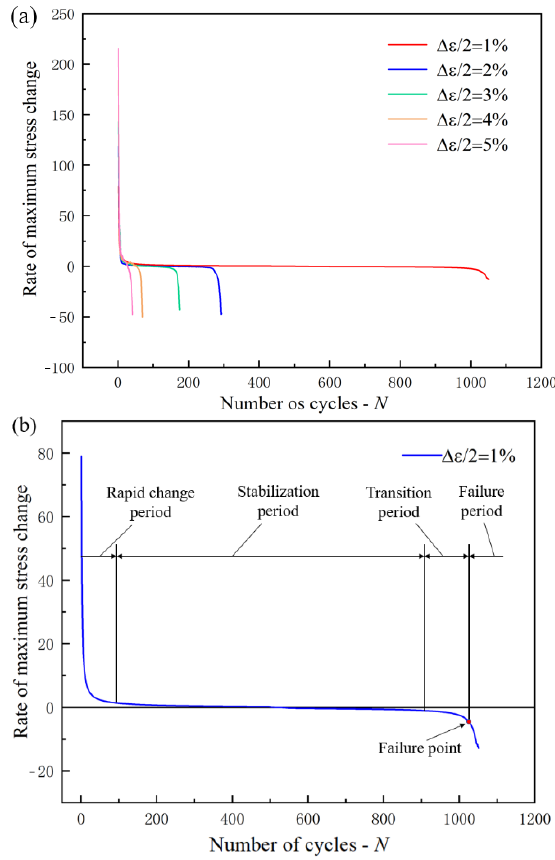
Figure 5. The change rate of the cyclic stress response curve of fatigue life: ( a ) the change rate of stress response curve under different strain amplitudes, ( b ) the change rate of cyclic stress response curves during 1.0% strain amplitude.